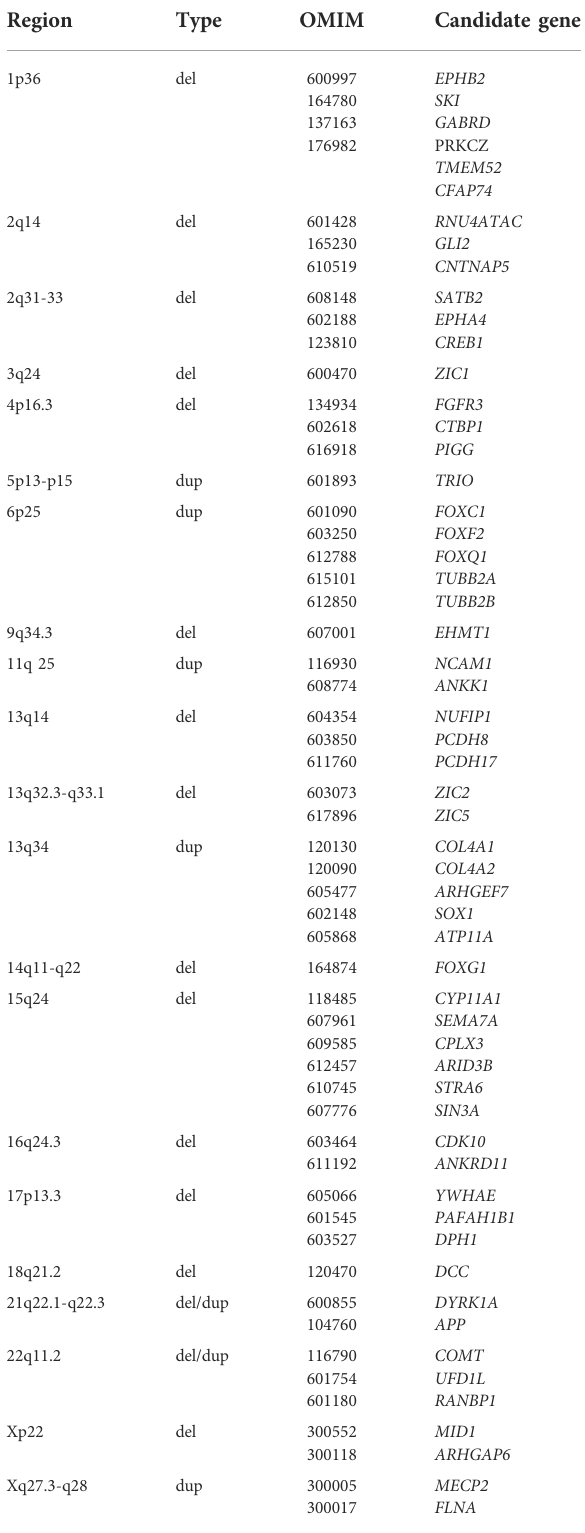
TABLE 1 Partial chromosomal anomalies and candidate genes associated with ACC (Dobyns 1996; Schell-Apacik et al., 2008; O ’ Driscolletal.,2010;Edwardsetal.,2014).Theitalicvaluesrepresent genes.